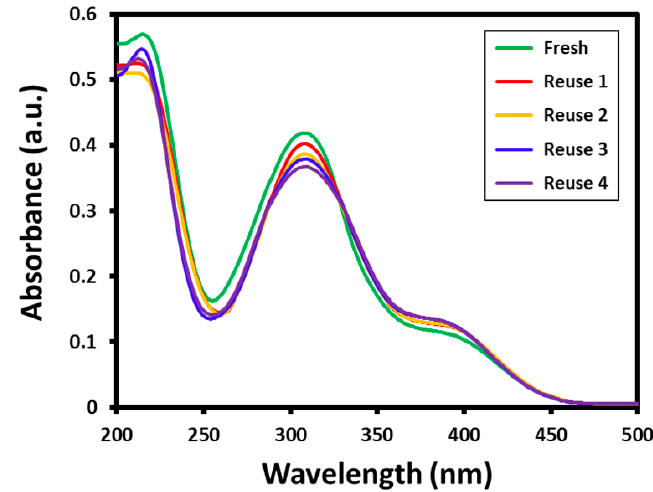
Figure 6. Reusability of Au-ZrO 2 nanocatalyst for the reduction of 4-nitrophenol. All the reactions are performed for 30 min using the same catalyst which was recovered by centrifugation.